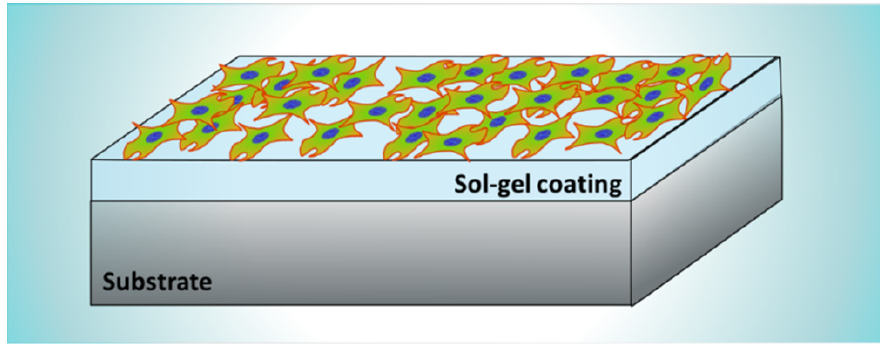
Figure 5. Schematics of cell culture proliferation on a sol-gel coating deposited on a metallic substrate.